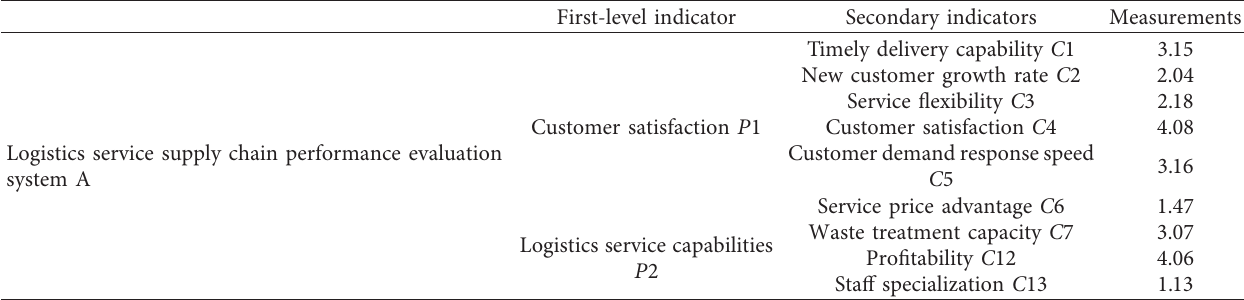
Table 2: Statistical values of quantitative indicators for the performance evaluation of S enterprise logistics service supply